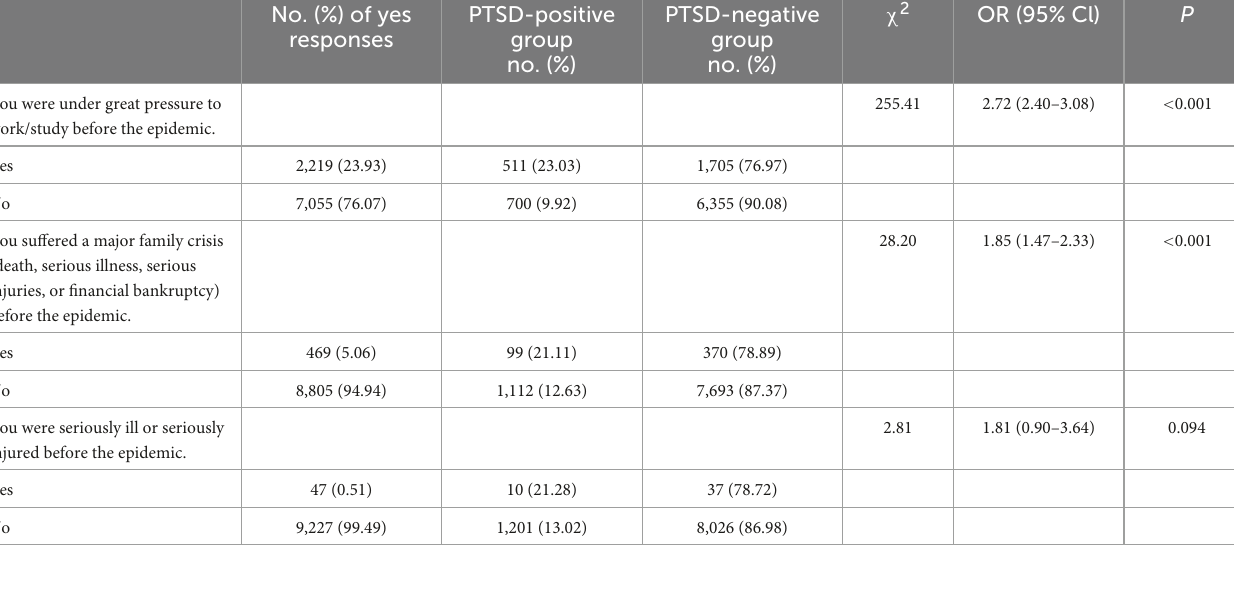
TABLE 5 Logistic regression model of PTSD symptoms development among Chinese college students a .